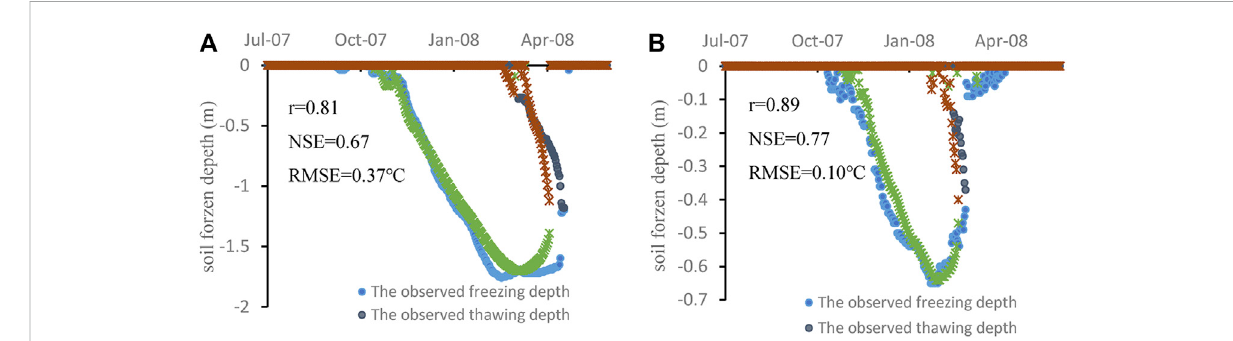
FIGURE 7 The simulated by using the inversion parameters and observed freezing and thawing processes at Dari station (A) and Suoxian station (B) from 1 July 2007 to 30 June 2008. At Dari, r, NSE and RMSE are 0.81, 0.67 and 0.37 ° C, respectively. At Suoxian, r, NSE and RMSE are 0.89, 0.77 and 0.10 ° C,